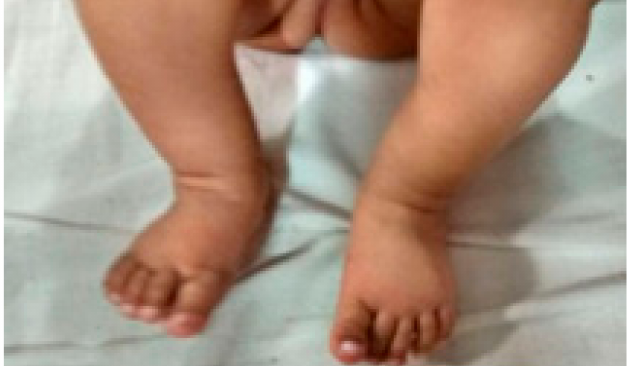
Figure 8. Clinical picture at last follow